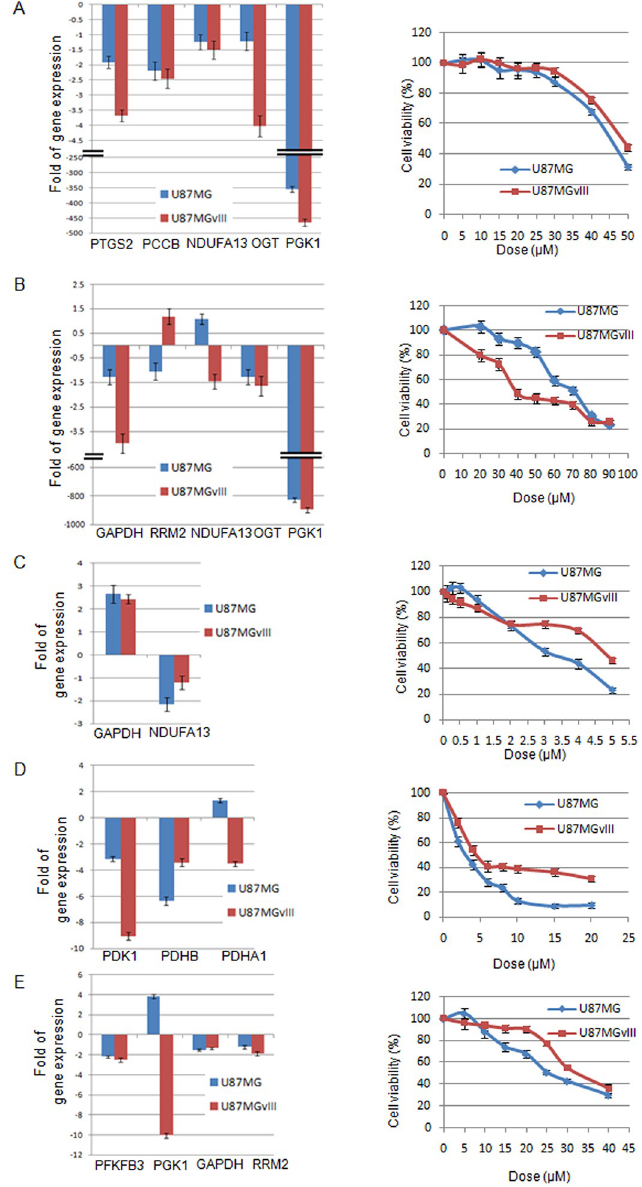
Fig 9. Test of the GBM-specific significant network model in cell cultures. The EGFRwt and EGFRvIII-mutated GBM cell lines U87MG and U87MGvIII were incubated with inhibitors for calmodulin (CALM2) with CGS 9343B (A) , casein kinase II subunit alpha (CSNK2A1) with Emodin (B) , 1-phosphatidylinositol 4,5-bisphosphate phosphodiesterase gamma-1 (PLCG1) with U73122 (C) , tyrosine-protein kinase ABL1 with Dasatinib (D) , and B-cell lymphoma 2 (BCL2) with ABT-199 (E) . The bar diagrams on the left show the effects of the inhibition of the expression of metabolic pathway proteins predicted to be interconnected to the targeted signaling pathway proteins. The line graphs on the right show the dose-dependent effects of the signaling protein inhibitors on the viability of the cells. The selected targets were calmodulin (CALM2), casein kinase II subunit alpha (CSNK2A1), 1-phosphatidylinositol 4,5-bisphosphate phosphodiesterase gamma-1 (PLCG1), the tyrosine- protein kinase ABL1 and B-cell lymphoma 2 (BCL2). The signaling-metabolic interconnecting paths including the selected proteins were extracted from the final GBM-specific significant